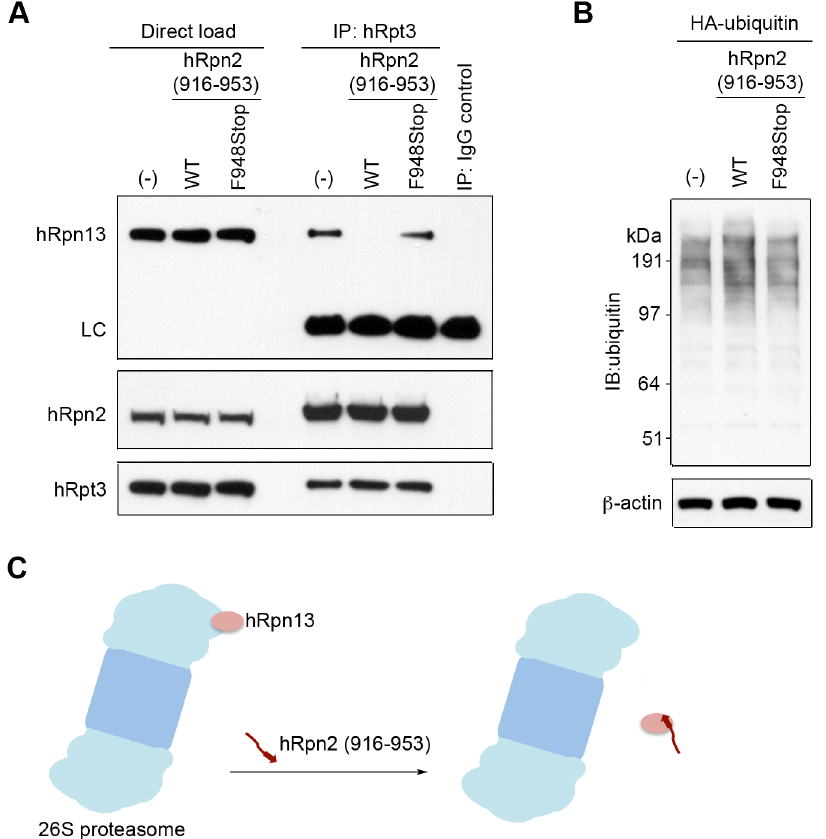
Fig 6. The hRpn2-derived peptide depletes hRpn13 from the proteasome. (A) 293T cells were transfected with p3XFLAG-CMV7.1-hRpn2 (916 – 953) WT or F948Stop plasmids and the cell lysates immunoprecipitated with anti-hRpt3 antibodies and immunoprobed with antibodies against hRpn13, hRpt3, and hRpn2, as indicated. (B) Cell lysates from 293T cells transfected with HA-ubiquitin alone or together with either p3XFLAG-CMV7.1-hRpn2 (916 – 953) WT or F948Stop plasmids were immunoblotted with anti- ubiquitin and anti- β -actin antibodies, as indicated. (C) A model illustrating hRpn2 (916 – 953) peptide interacting with hRpn13 and displacing it from the